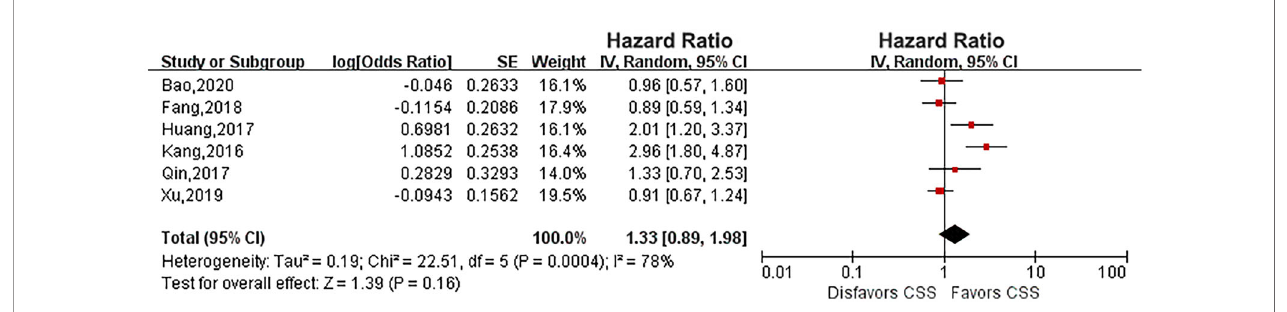
FIGURE 2 | Forest plot of the impact of diabetes on cancer-speci fi c survival.